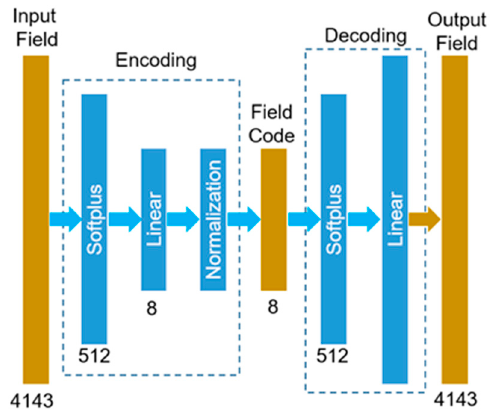
Figure 5. The structure and data flow of an autoencoder.